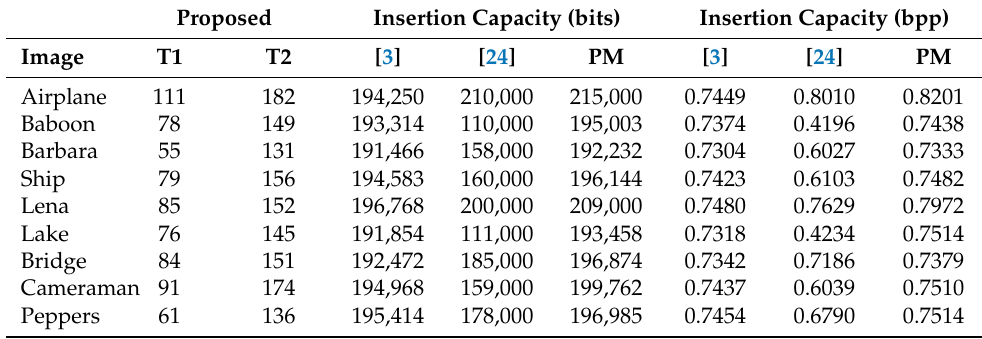
Table 2. A comparison of the actual embedding capacities in common images.